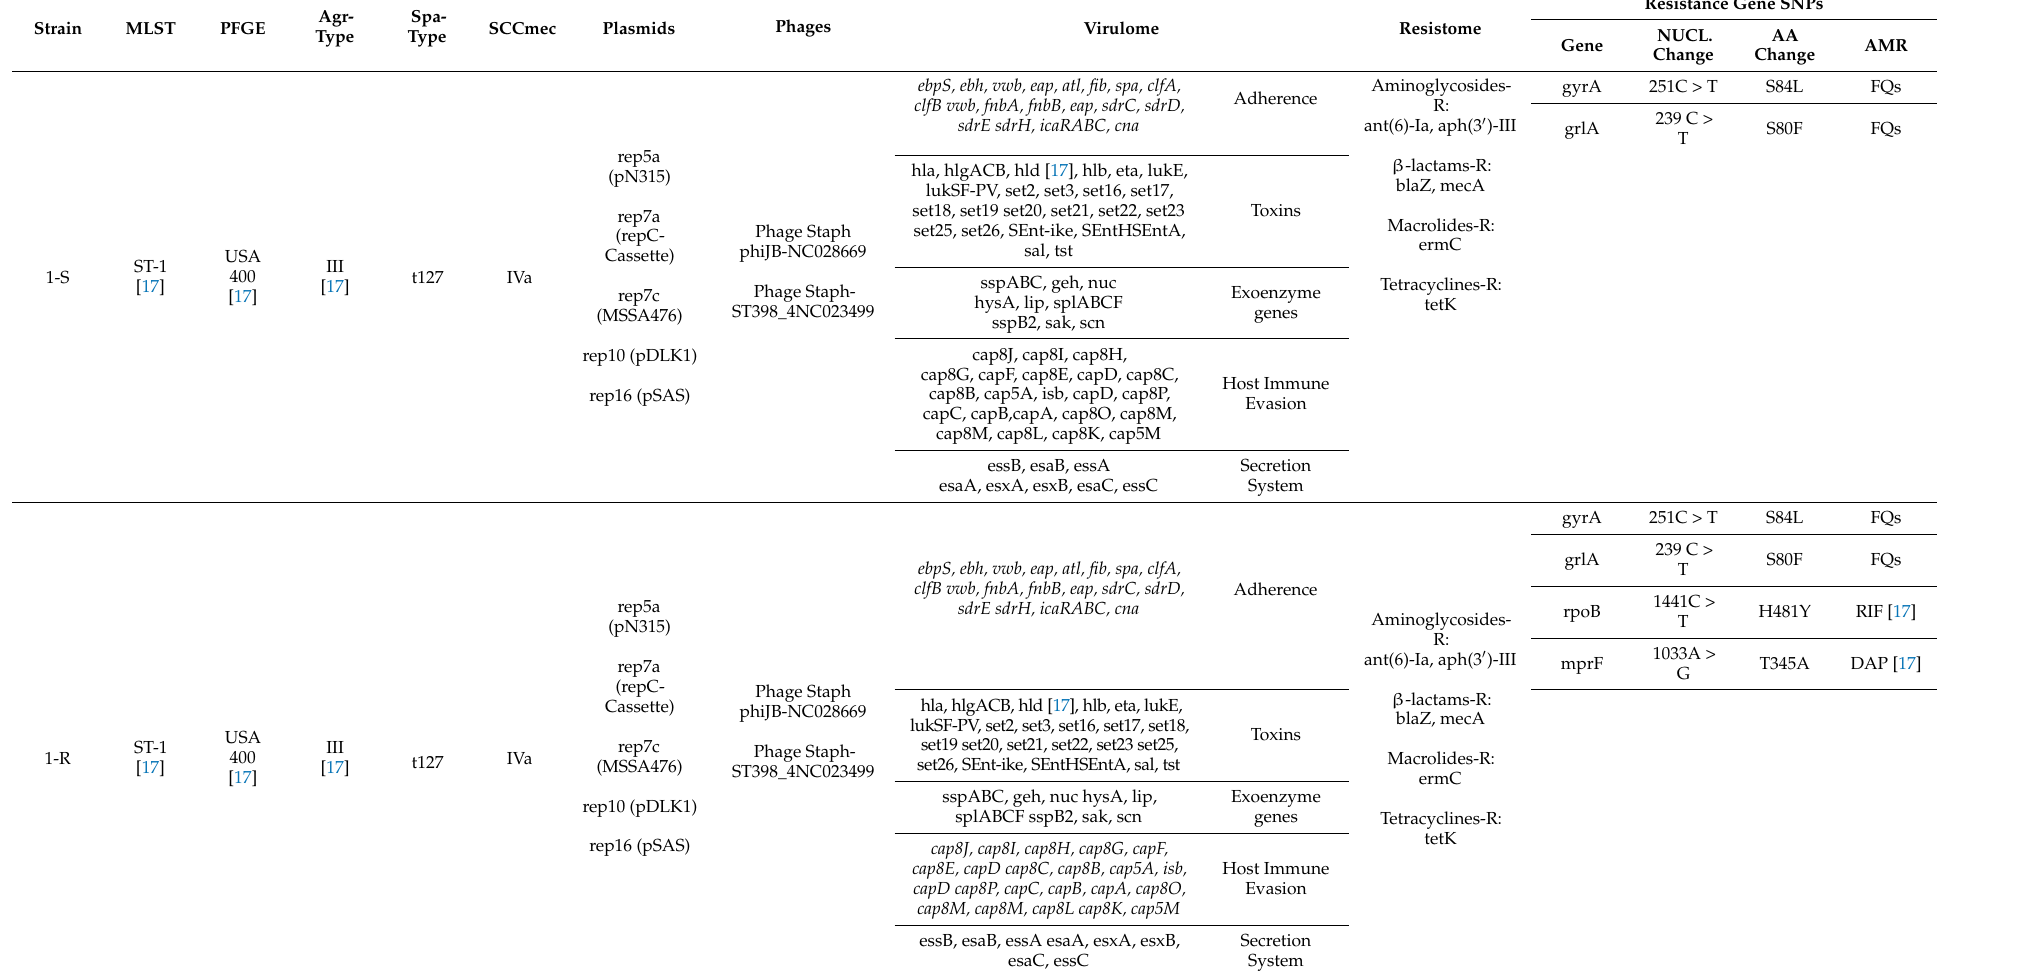
Table 3. Genomic, resistomic and virulomic